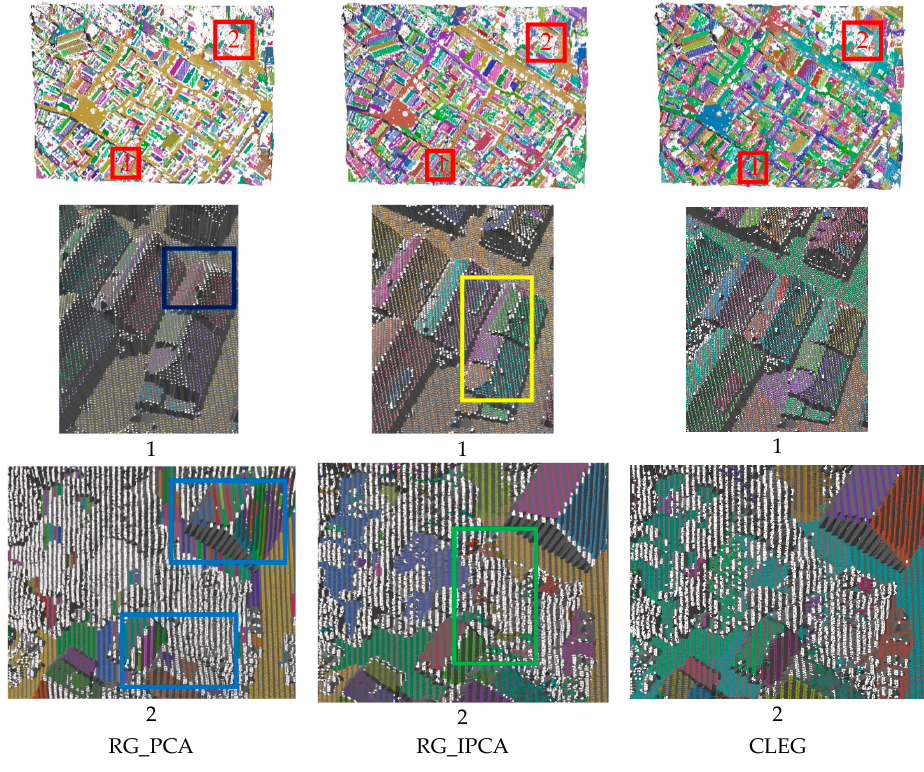
Figure 12. Segmentation results in the Vaighingen area using dataset (a). Segmentation results of the point cloud in the Wuhan area using a small dataset.